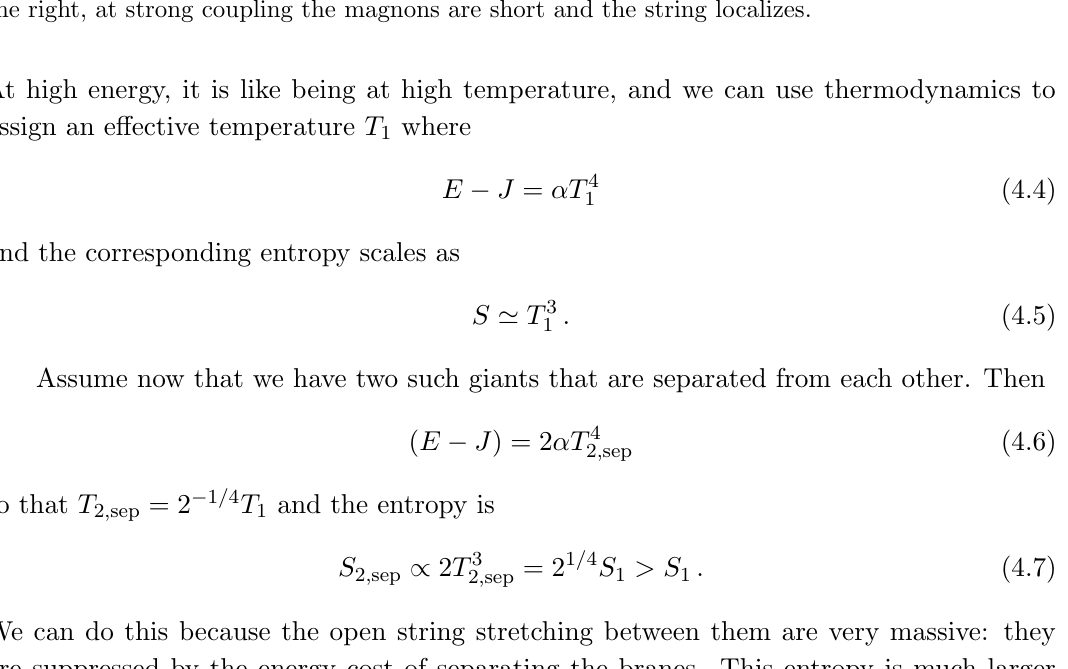
Figure 1 . One the left, at weak coupling there is no cost in energy to have long magnons. One the right, at strong coupling the magnons are short and the string